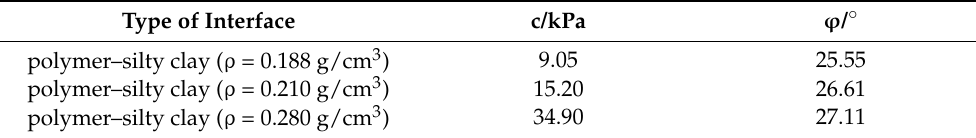
Figure 8. The relationships between the shear stress and the shear displacement of the interface under different polymer densities. Table 7. The shear strength indexes of the interfaces with different polymer densities.